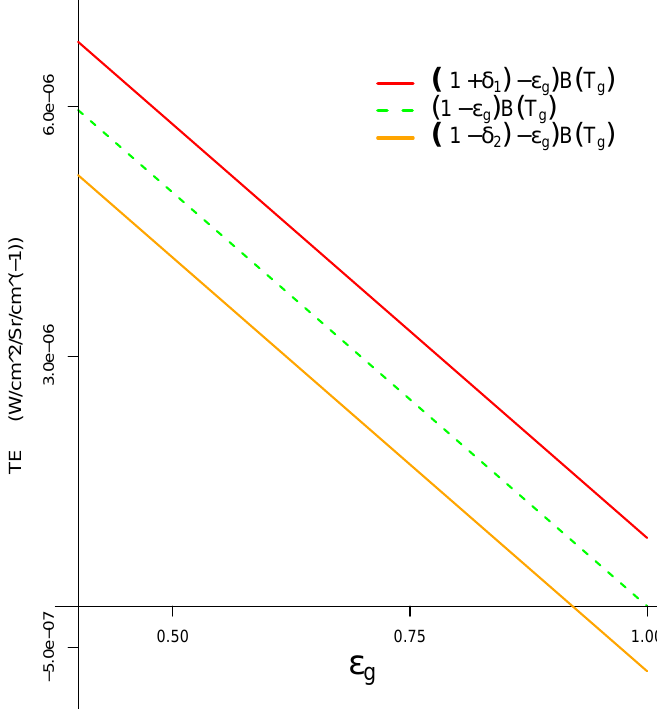
Figure 1. Temperature emissivity contrast plotted as a function of emissivity for three tem- perature cases at ν = 1000 cm − 1 : 305 K = T (green dashed line), and 295 = T